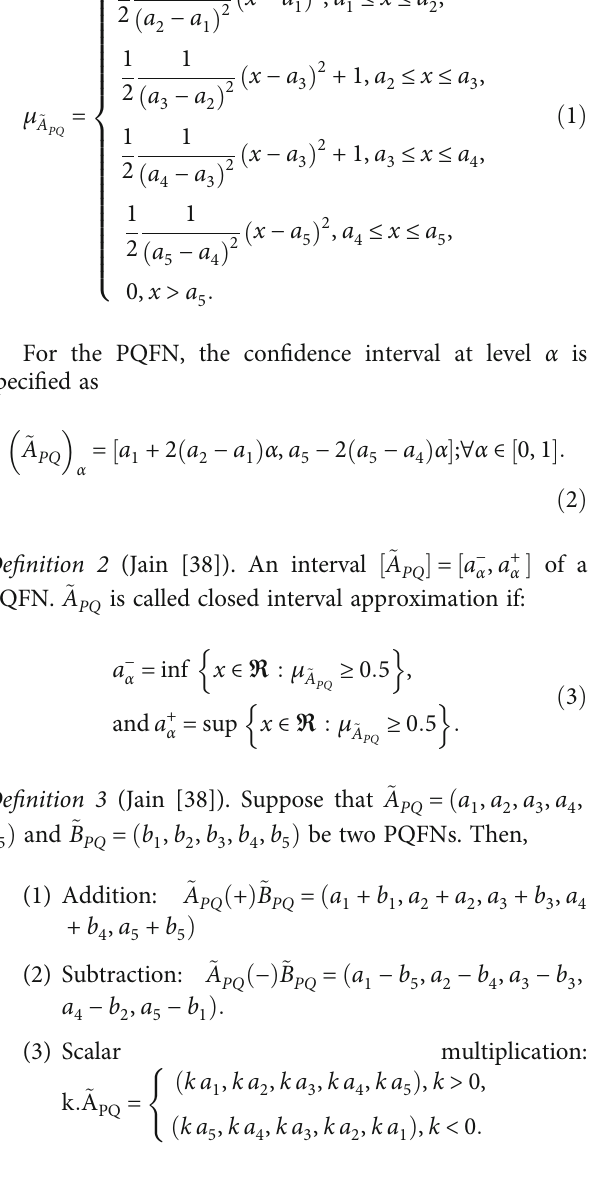
Figure 2: Graphical representation of PQFN